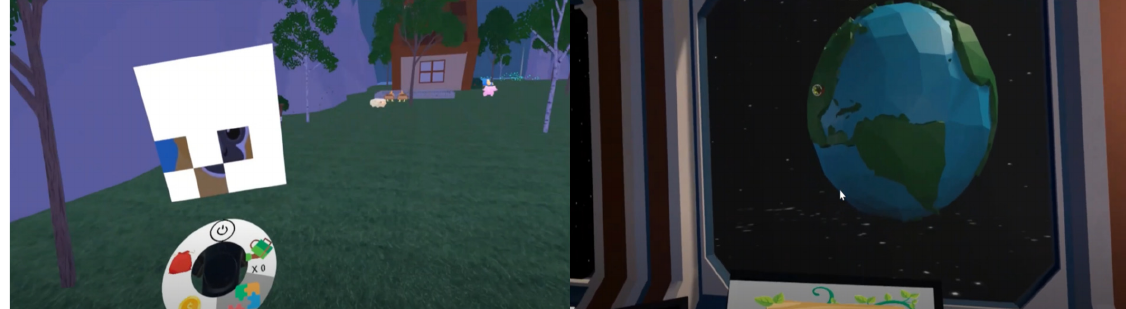
Figure 10. Endangered species puzzle pieces collected in the village (left), quiz scene (right).